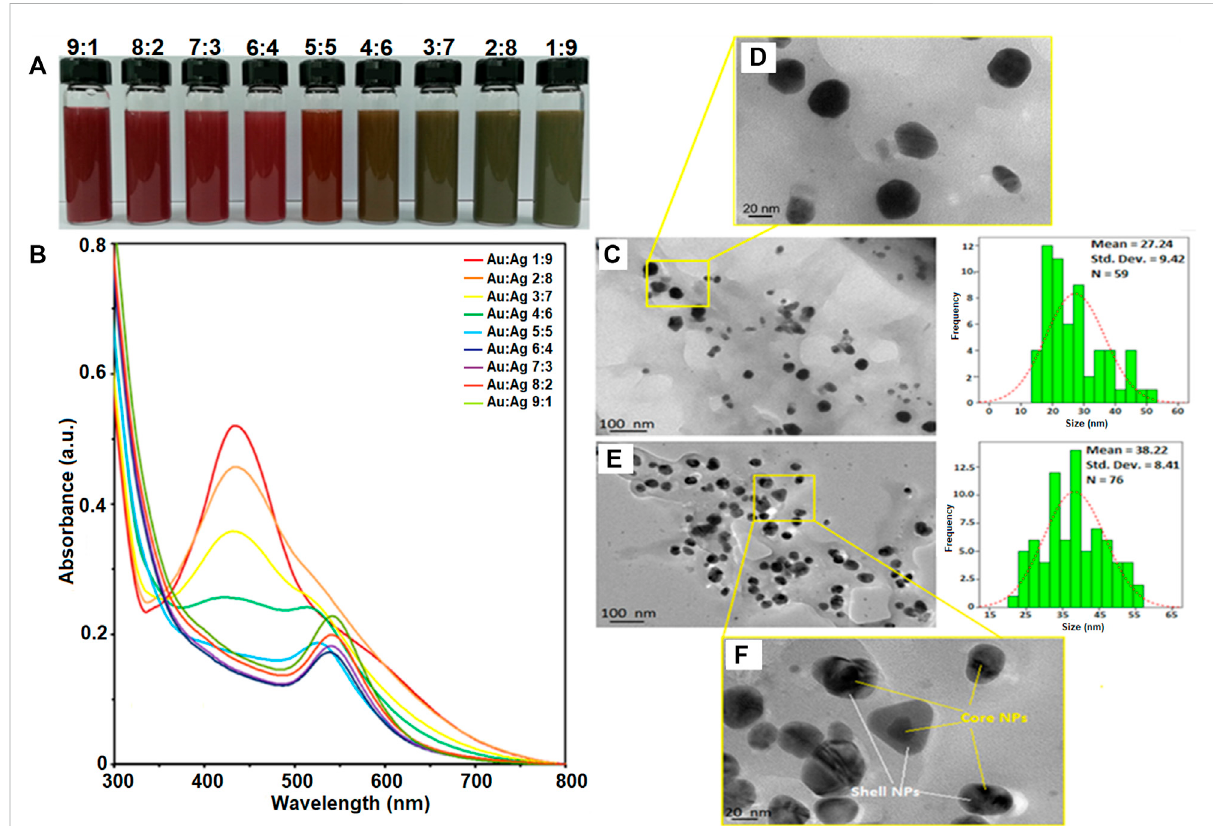
FIGURE 1 Characterisation of gold-silver core-shell nanoparticles (Au-AgNPs). (A) Colour changes of reaction, (B) UV-vis spectra of the sample at different ratios of Au:Ag, (C) Size and shape of sample Au:Ag 9:1 by TEM image, (D) Zoomed in TEM image of sample Au:Ag 9:1, (E) Size and shape of sample Au:Ag 1:9 by TEM image and (F) Zoomed in TEM image of sample Au:Ag